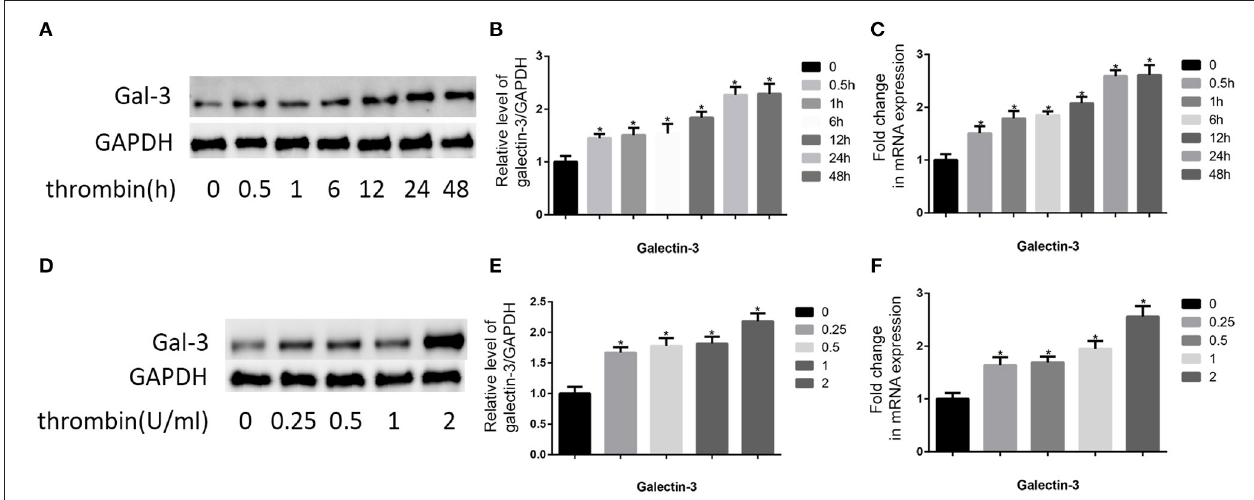
FIGURE 1 | Thrombin increased gal-3 expression in VSMCs and cell migration. Cells were treated with thrombin over a range of concentrations (0, 0.25, 0.5, 1, and 2 U/ml) for different times (0, 0.5, 1, 6, 12, 24, and 48h) and gal-3 expression was measured by Western blot (A,D) or qRT-PCR (C,F) . Quantification of Western blot results is shown (B,E) . Band density of native VSMCs was defined as a control and considered to 1. * p < 0.05 compared with